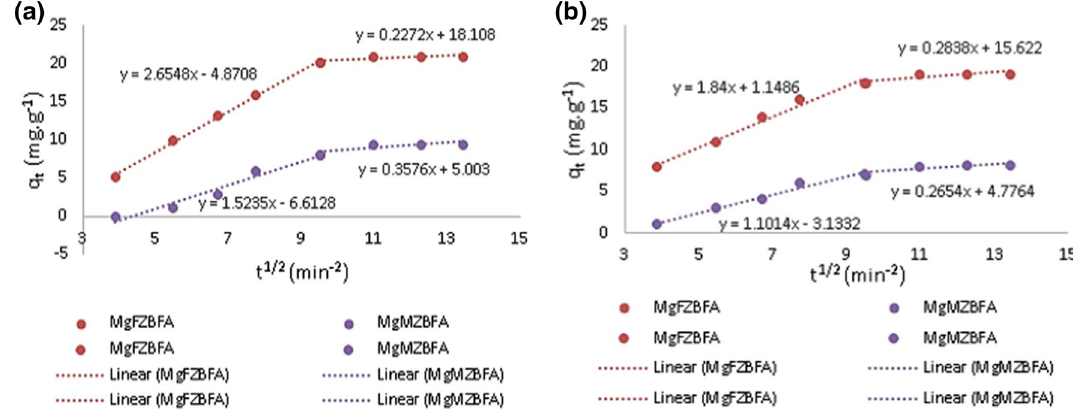
Fig. 18 Intraparticle diffusion model plots for the adsorption of a PNAN, b NB on MgFZBFA and MgMZBFA